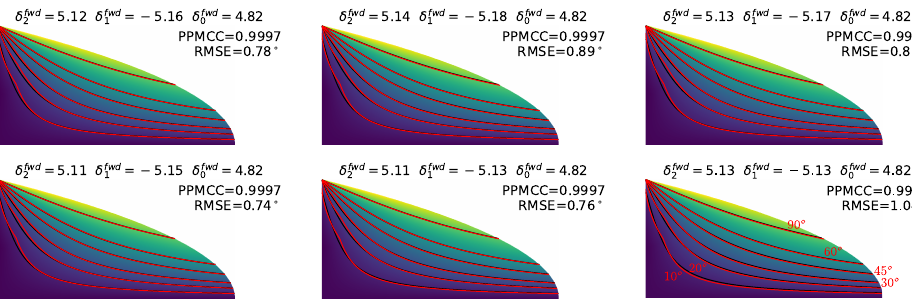
Figure 10. Distribution and contours (in red) of FWD–GCA metric for evaluating Putnin.š P 4 (Craster Parabolic) projection using rational function–based regression with different regression coefficients.